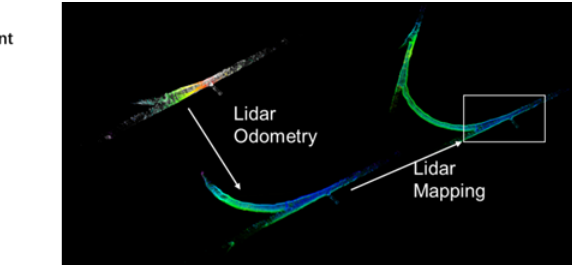
Figure 1. Distance-weight map localization system flow.